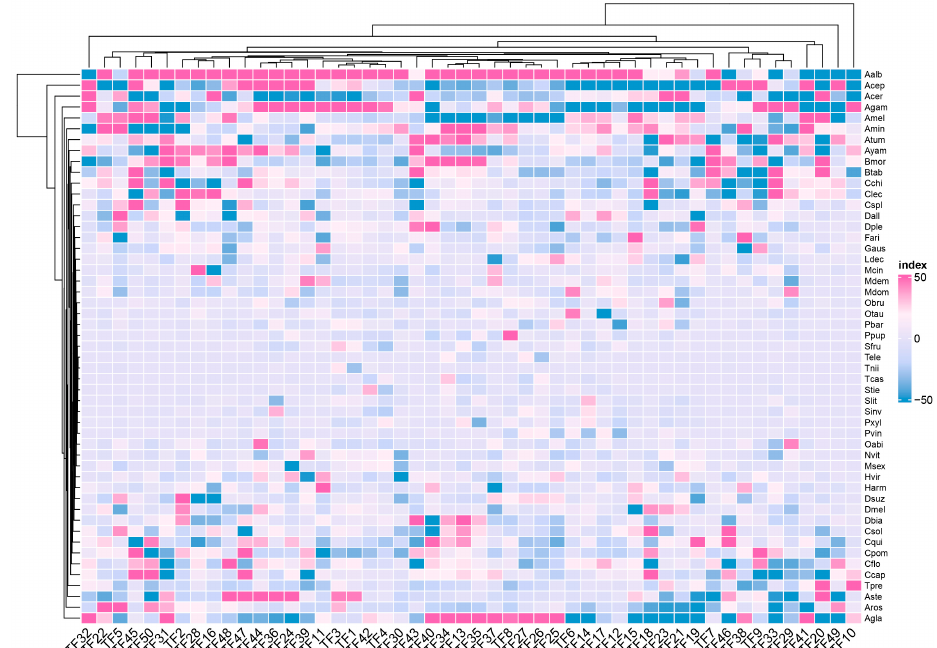
Figure 2. Characteristic heat map of PCA, the vertical axis is the name of insects, and the horizontal axis is the eigenvalues of different features. See Table S2 for the names of species assigned to each label.